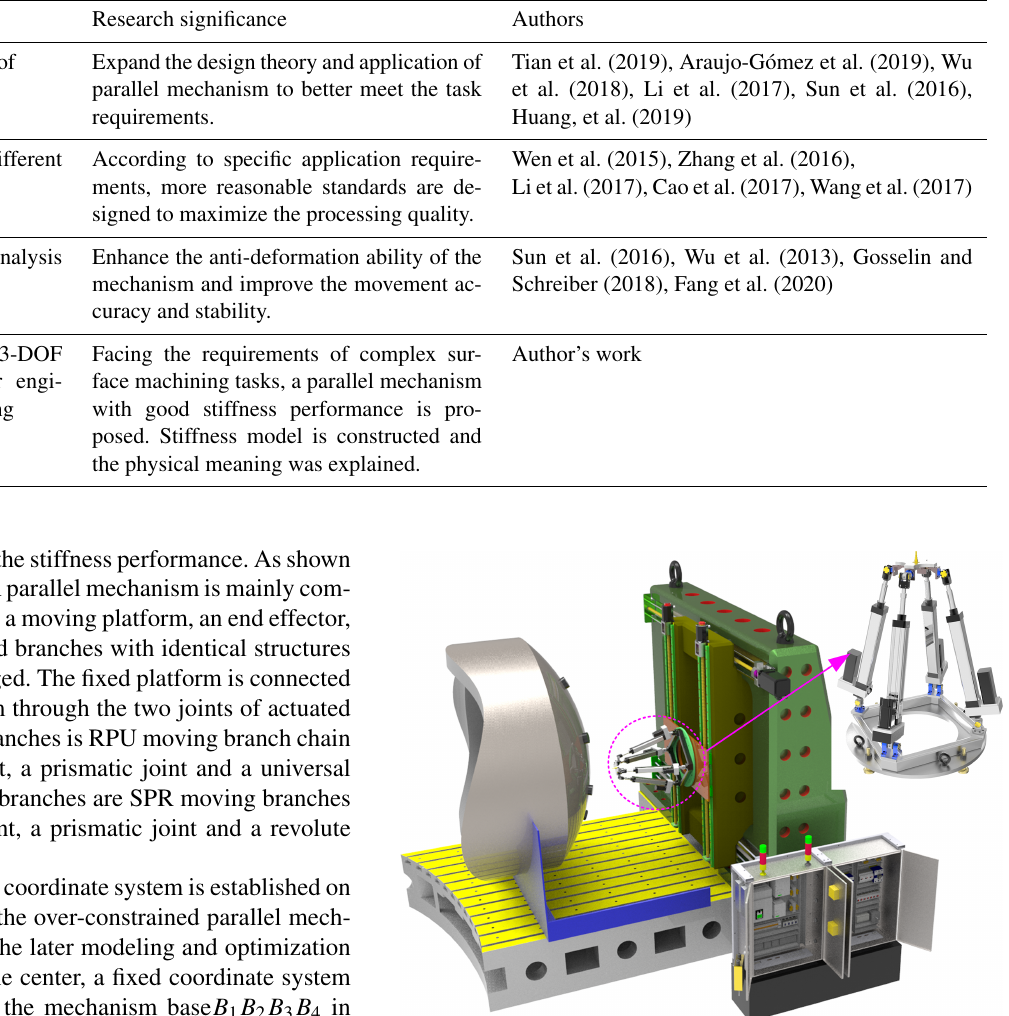
Table 1. Relevant concepts associated with stiffness analysis of parallel mechanism.